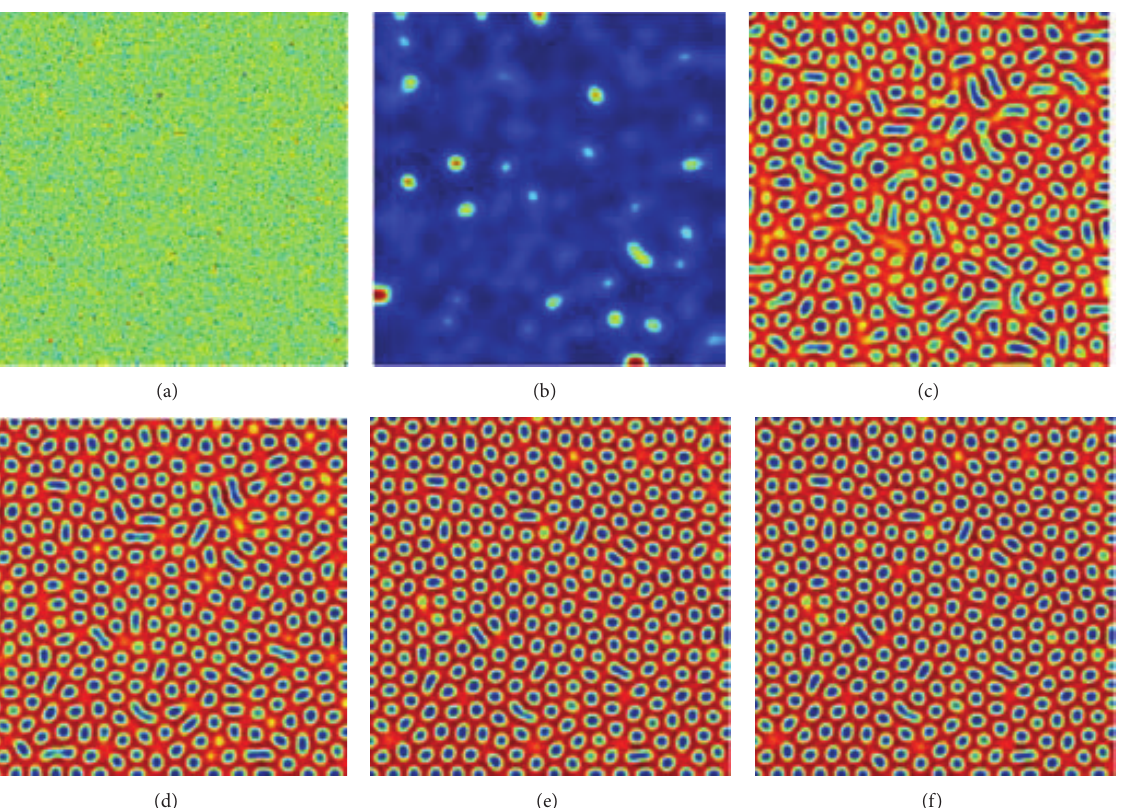
Figure 6: Spatial pattern of prey population at different time. Parameters set: 𝛾 = 1.5 , 𝜀 = 0.15 , and 𝛿 = 1.04 . (a) 𝑡 = 0 ; (b) 𝑡 = 100 ; (c) 𝑡 = 300 ; (d) 𝑡 = 500 ; (e) 𝑡 = 1000 ; and (f) 𝑡 = 2000